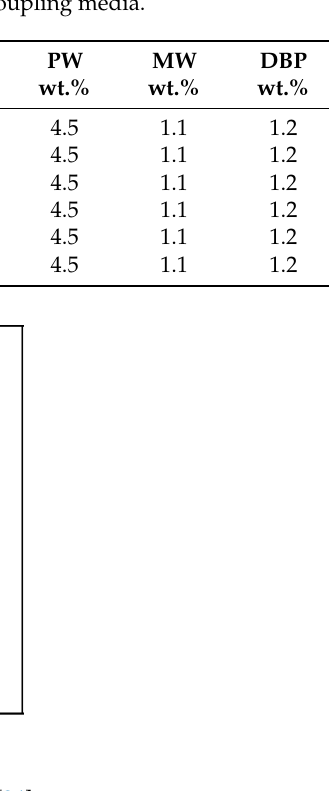
Table 1. Compositions of the samples with different coupling media.